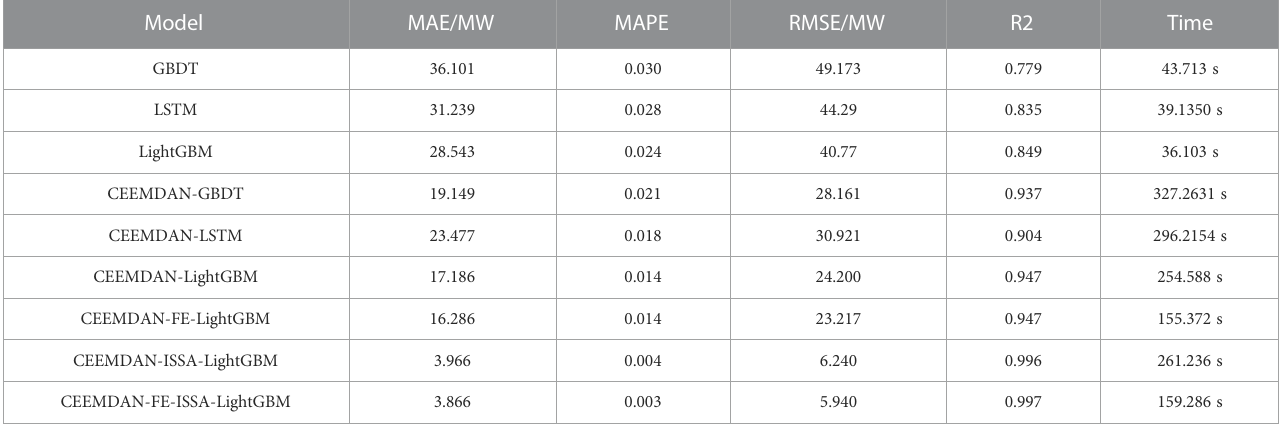
TABLE 7 Error of the proposed model versus a single model in Case